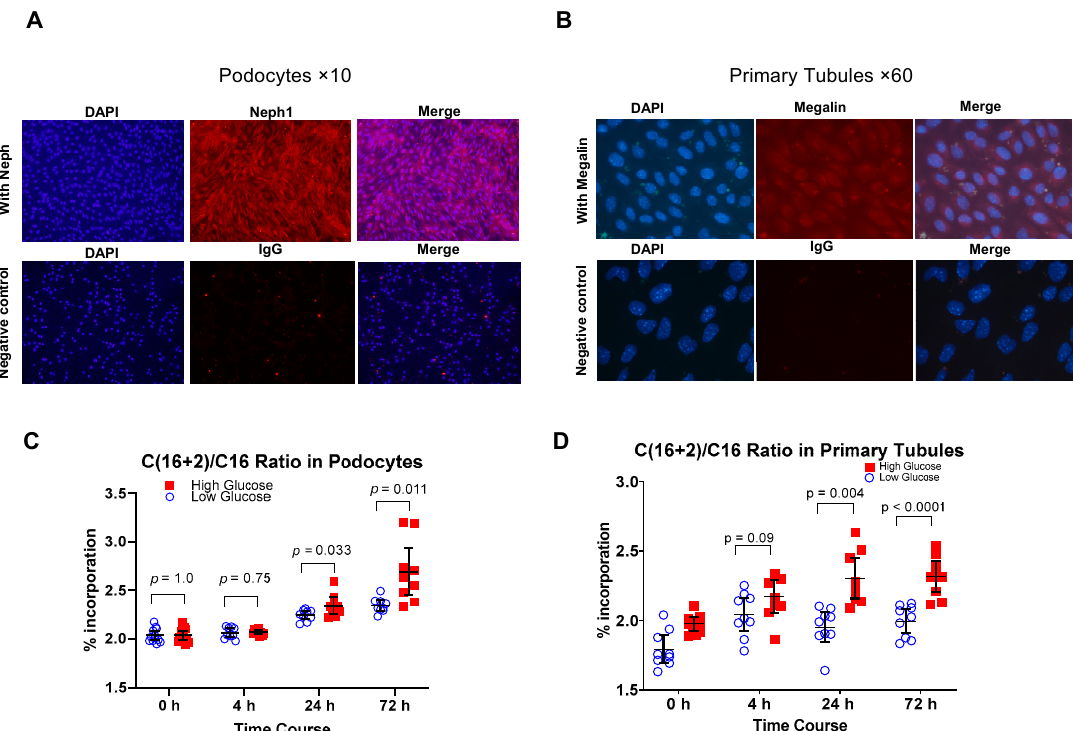
Figure 1. Upregulation of DNL with hyperglycemia in podocytes and primary tubular cells. Im ‐ muno ‐ staining with cell ‐ specific markers was used to confirm podocytes and primary tubular cells, Showing NEPH1 staining for podocytes ( A ) and megalin for primary tubular epithelial cells ( B ). Increased percentage of labeled palmitate with exposure to high glucose concentration (25 mM) at 24 and 72 h compared to low glucose concentration (5.5 mM) media in podocytes ( C ) and primary tubular cells ( D ) indicates upregulation of de novo lipogenesis by high glucose concentration. Num ‐ ber of experiments is 3, each time in triplicates for panels C and D. Values are mean and 95% confi ‐ dence interval.